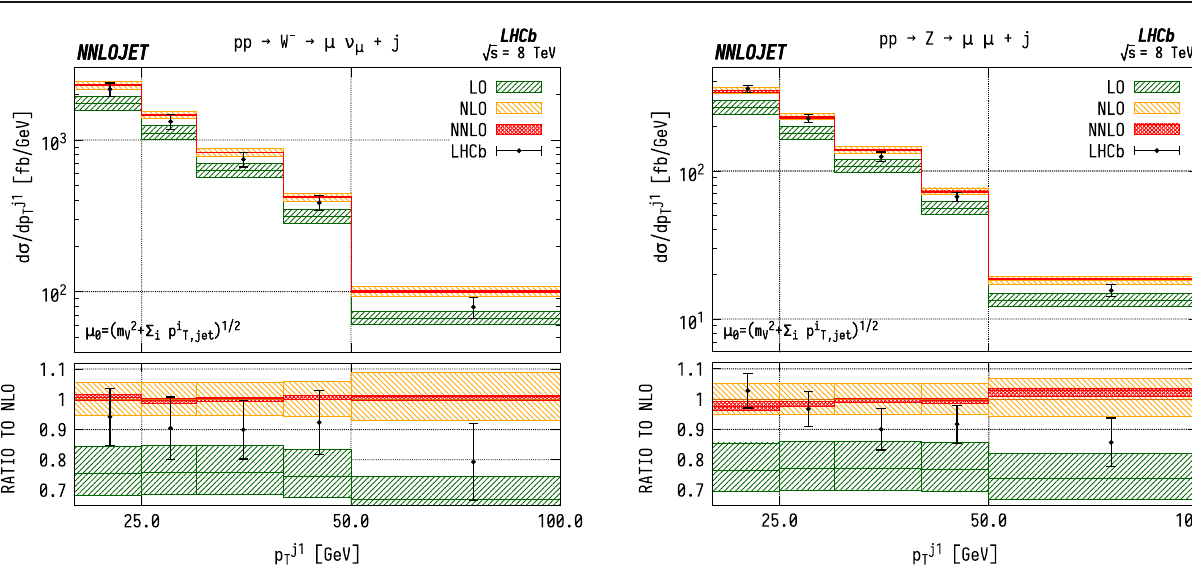
Fig. 3 Cross section differential in the p T of the leading jet for W − production. Predictions at LO (green), NLO (orange), and NNLO (red) are compared to LHCb data from Ref. [16], and the ratio to NLO is shown in the lower panel. The bands correspond to scale uncertainties estimated as described in the main text